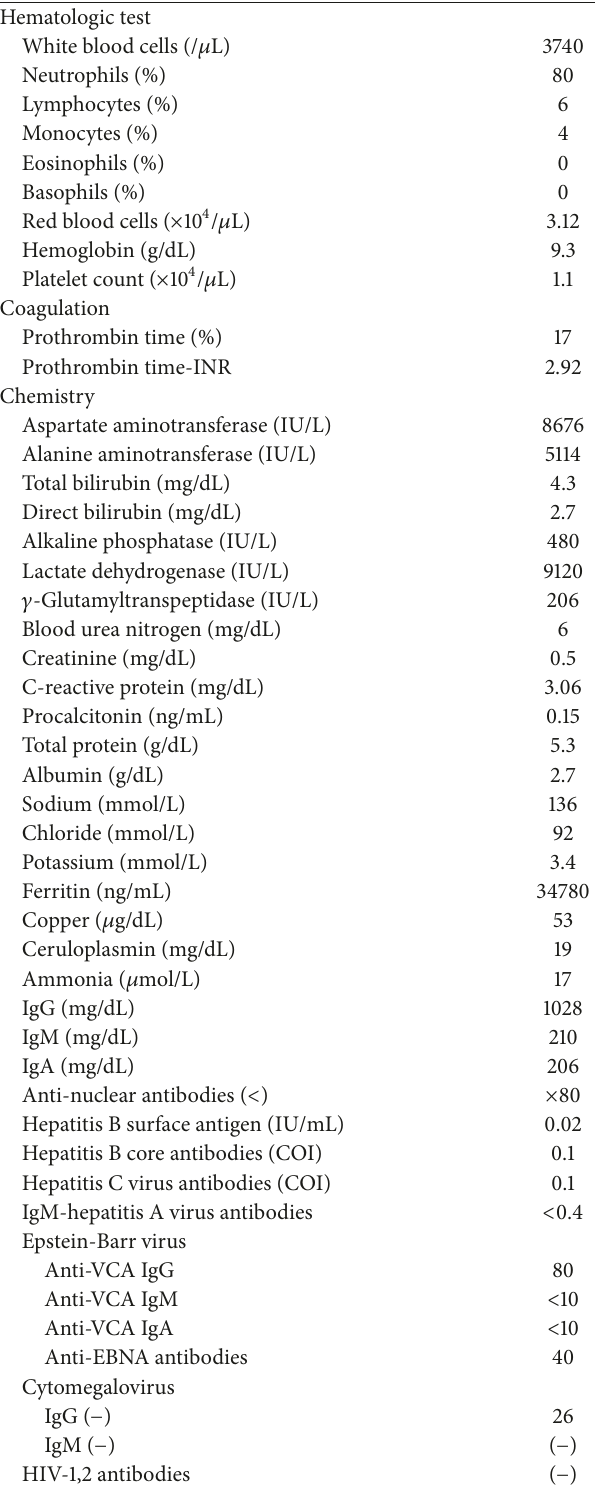
Table 1: Laboratory data at time of